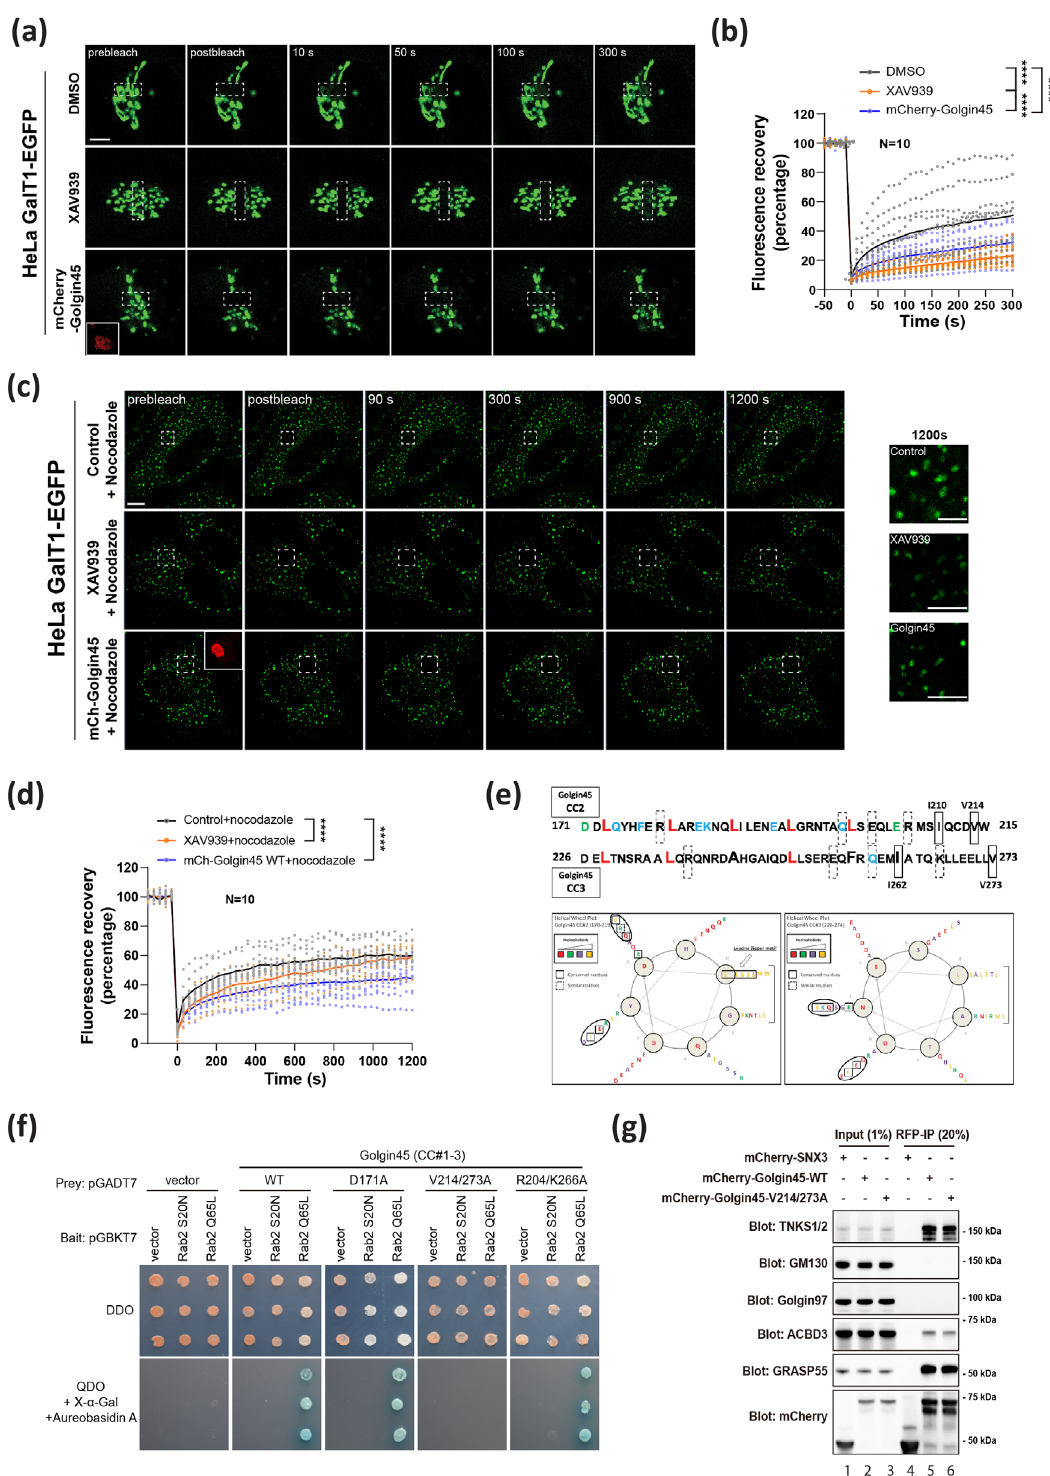
Glycosylations, such as increased sialylation and multi- branched N-glycans, have been shown to play important roles during development 32,33 , and aberrant N-glycosylations have long been regarded as a hallmark of oncogenic transformation and shown to contribute to increased invasiveness and metastatic potential 37 – 41 . Therefore, it makes sense that a regulator of Wnt/ β -catenin signaling also modulates protein glycosylation at the Golgi, albeit in an unexpected